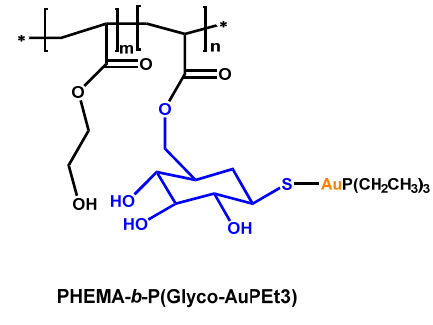
Figure 8. Block copolymer complex